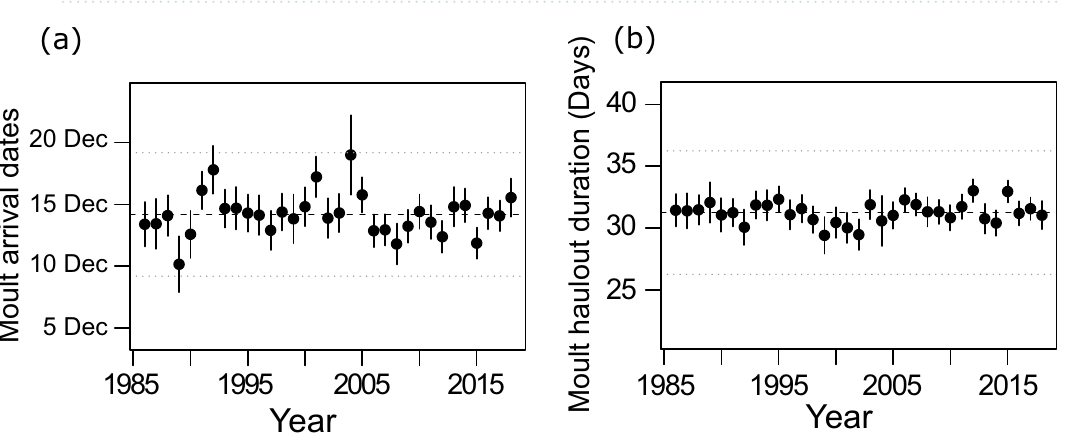
Figure 2. Conditional means (with 95% confidence intervals) of the random effect intercepts that describe the predicted annual deviation in ( a ) moult arrival dates and ( b ) moult haulout duration from the long-term (1986– 2018) population-mean value (dashed line). Dotted lines indicates a 5-day shift from the population